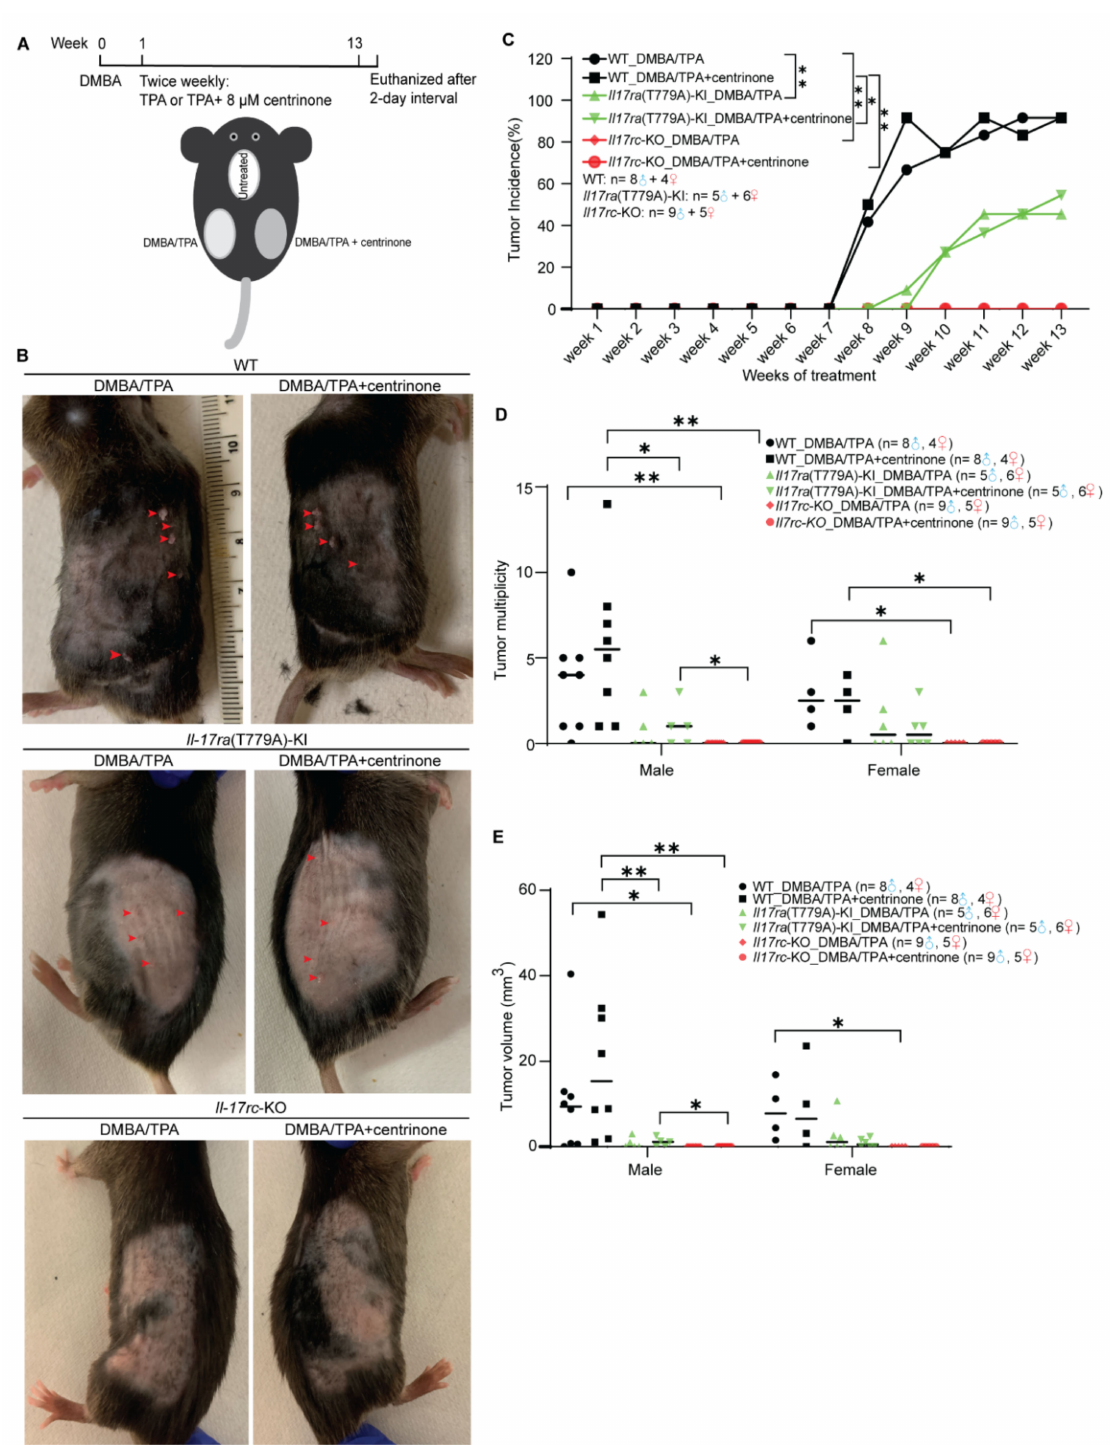
Figure 6. Mutation of T779A of Il17ra and knockout of Il17rc prevent the development of skin papilloma. ( A ) Diagram of establishing DMBA/TPA-induced two-stage skin papilloma mouse model. ( B ) Representative of tumors or nodules of WT, Il17ra (T779A)-knockin, and Il17rc -knockout C57BL/6J mouse strains. Arrowheads indicate papillomata ( ≥ 1 mm) and nodules (<1 mm). ( C – E ) Plots demonstrate tumor incidence, tumor multiplicity, and tumor volume. Statistical signif- icance was assessed with a two-tailed Student’s t test and two-way ANOVA. Error bar represents mean ± SD. *— p < 0.05; **— p < 0.01. The number of male and female mice in each subgroup are indicated in the